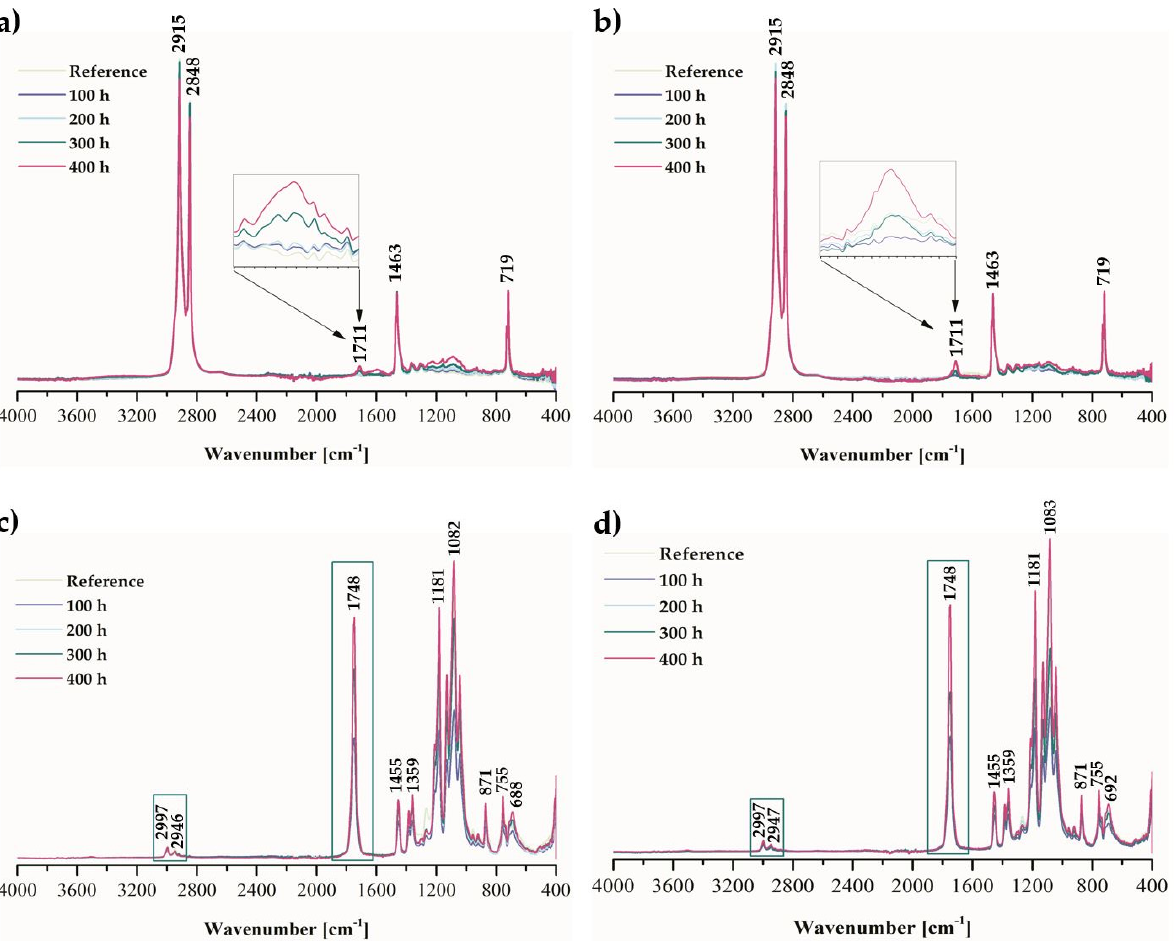
Figure 3. Fourier-transform infrared spectra of ( a ) pure ethylene-norbornene copolymer (Topas), ( b ) Topas with CBD extract, ( c ) pure polylactide (PLA), ( d ) PLA with CBD content, before and after 100, 200, 300, and 400 h of weather-aging.